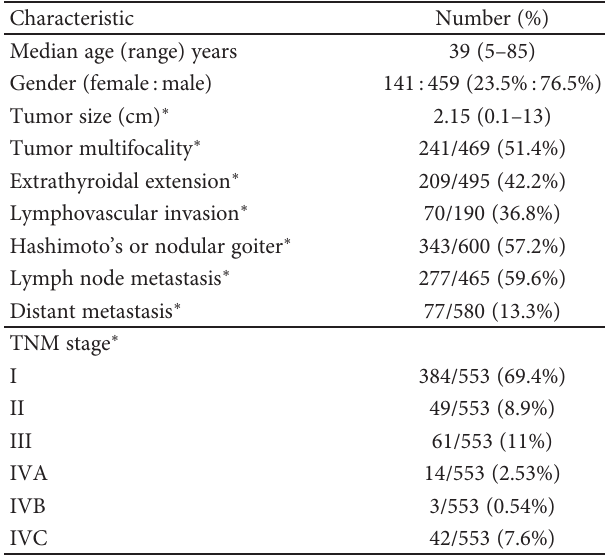
Table 1: Characteristics of 600 cases of follicular cell-derived thyroid cancer seen during the period 2004-2005.